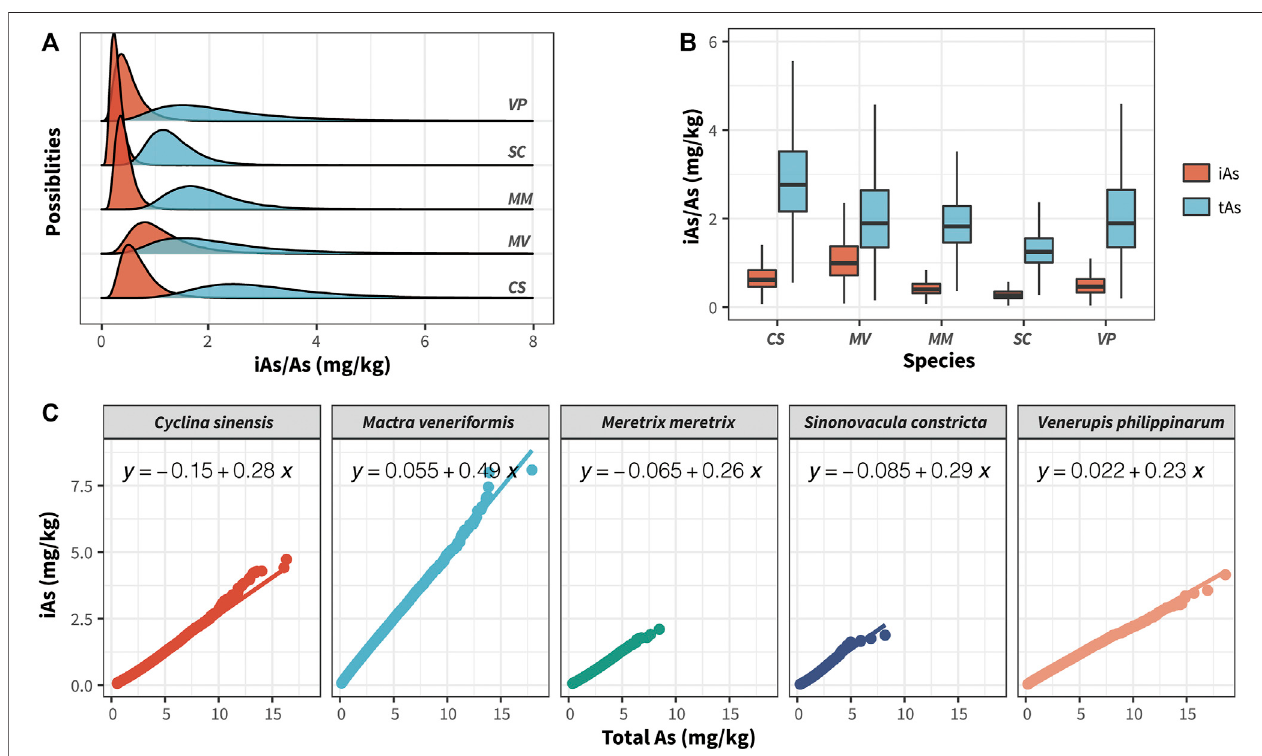
FIGURE 6 | Posterior probabilistic distributions of iAs (blue) and tAs (red) concentrations in different clam species cultivated in Jiangsu Province (A) ; Boxplot of posteriorprobabilisticdistributionsofiAsandtAsconcentrationsindifferentclamspecies,thebottomandtopoftheboxesrepresentthe25thand75thpercentiles,while error bars represent the 5th and 95th percentiles. The solid lines inside the box represent the median As concentrations (B) ; Pearson ’ s correlation analysis of posterior distributions of iAs and tAs among different clam species (C) .